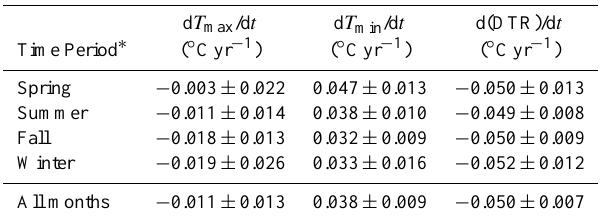
Table 2. Best-fit annual mean trend line slopes, d T max /d t , d T min /d t , and d(DTR)/d t , based on hourly temperature data (NOAA, 2009) from the Mauna Loa Observatory, Hawaii, 1977–2006, given for four seasons (spring, summer, fall, winter) and all months. Trend lines for summer, winter and all months are given in Fig. 6. Uncer- tainties are ± 1 s.e. of the